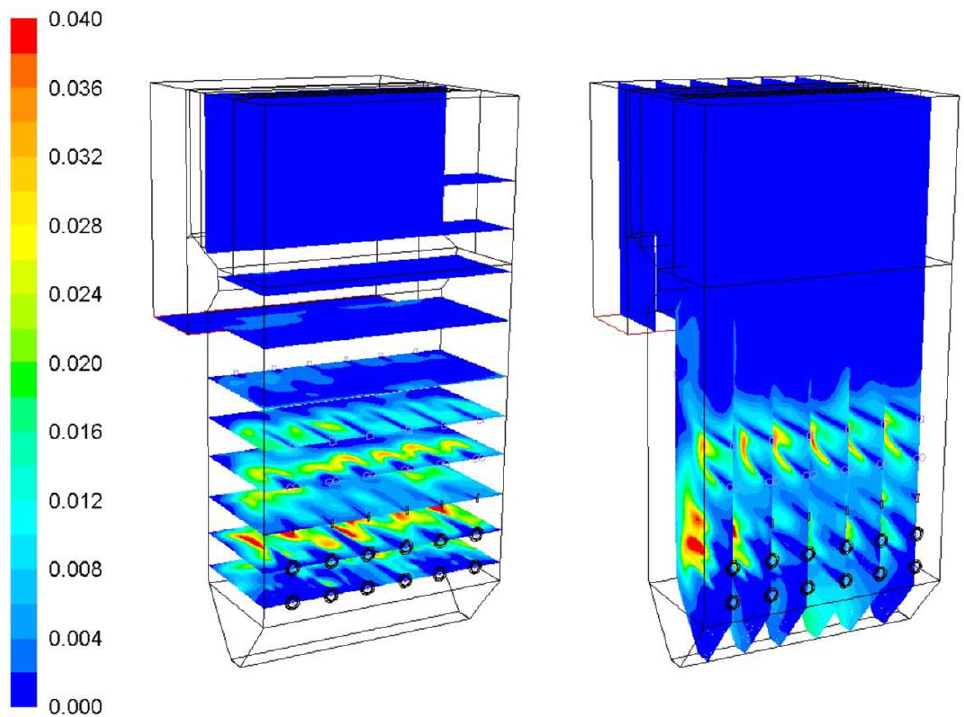
Figure 9. The mass fraction of CO in the planes of the burner axis. The concentrations of nitrogen oxides in various sections of the boiler are shown in Figure 10. This model is the base model for the subsequent SNCR model calculations.